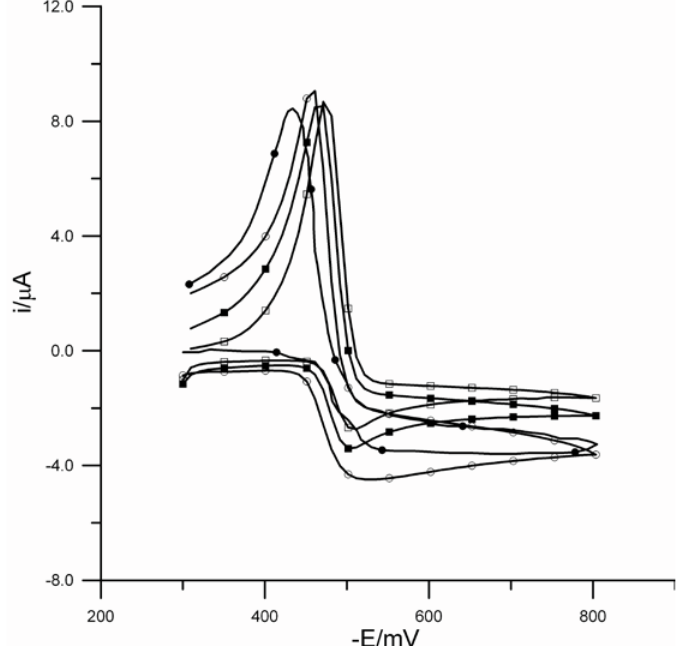
pH 2 in the presence of MTU. The concentration of MTU in 4